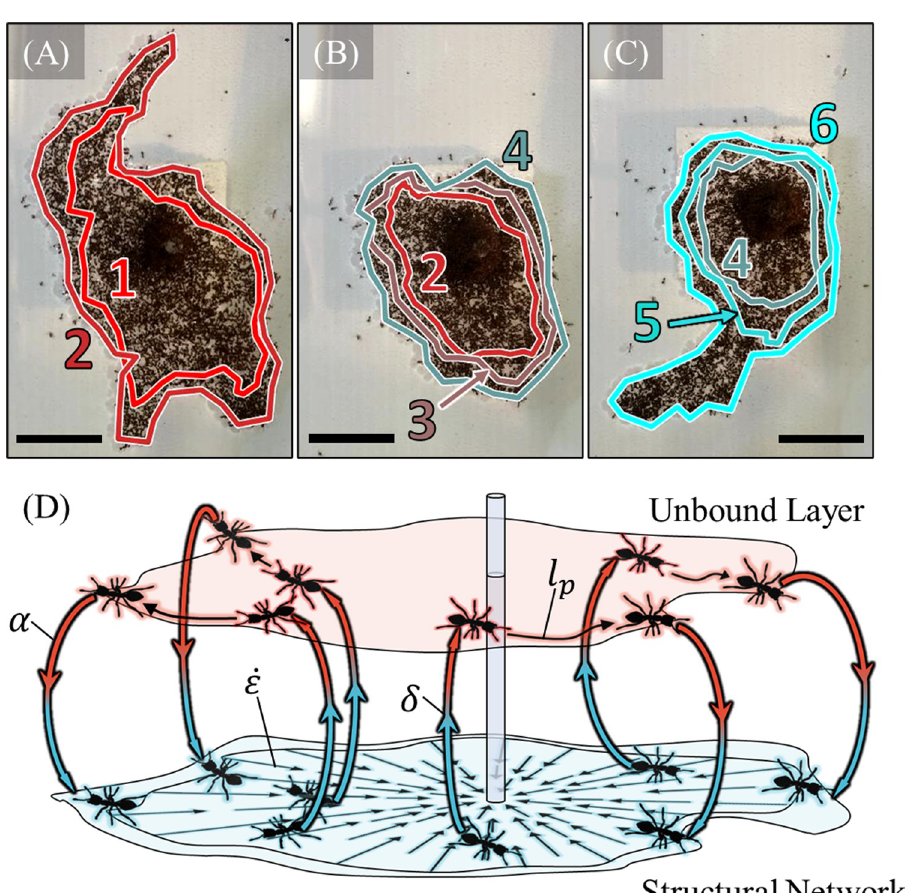
Fig 1. Treadmilling. (A-C) A top view of the same experimental raft is illustrated at the (A) start , (B) middle, and (C) end of a roughly 106 min duration. To visually illustrate treadmilling, a set of structural ants at the perimeter is selected every 22 minutes. These ants are then image-tracked as they flow inwards due to network contraction and the geometry defined by these ants is traced by a distinctly colored and numbered outline. The set of ants labeled “2” in (B) , for example, corresponds to the same set of ants labeled “2” in (A) , but roughly 53 min later. The label “1” represents the oldest set of ants while “6” represents the newest. The shrinking of these contours indicates retraction of the raft structure, while the existence of new layers indicates outwards expansion. Periods of raft expansion and coinciding protrusion emergence (A,C) were interrupted by interstitial spans of decreased activity and less eccentric morphologies (B) . All scale bars represent 10 ℓ where 0 mm is the approximate average body length of 1 ant. See S1 Movie for unannotated video. (D) A schematic visually illustrates the four concurrent mechanisms of treadmilling: (1) structural raft contraction at a global rate _ ε , (2) transition of structural ants to freely active ants in the bulk at a nominal rate δ , (3) transport of the free ants on top of the raft with a mean persistence length l p , and (4) binding of free ants back into the structural network at the edges of the raft at nominal rate α . The schematic is taken from Wagner, et al. (2021) [14]. The freely active layer is offset from the structural layer for illustrative purposes only, as it resides directly on top of the structural network in real ant rafts. Furthermore, note that the freely active layer, while shaded continuously, is comprised of dispersed ants while the structural layer is relatively homogeneous and condensed.